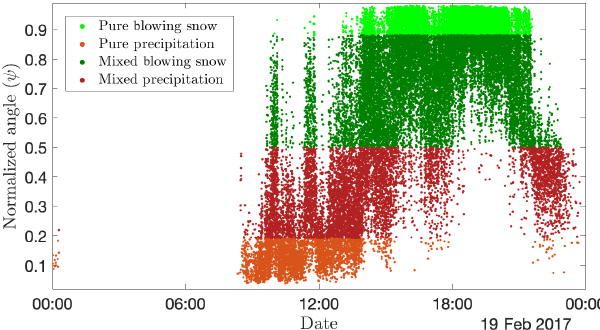
Figure 13. Time series of classified MASC images and correspond- ing ψ values (averaged over the three views) for a mixed event dur- ing the Antarctica 2017